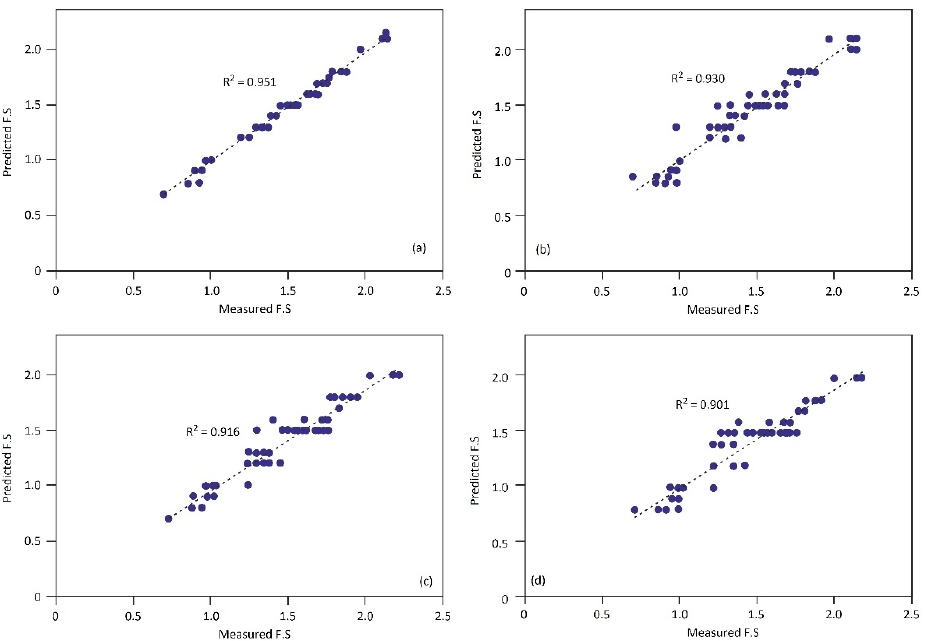
Figure 3. Measured and predicted correlation for training results: ( a ) MLP, ( b ) SVM, ( c ) DT, ( d ) RF.